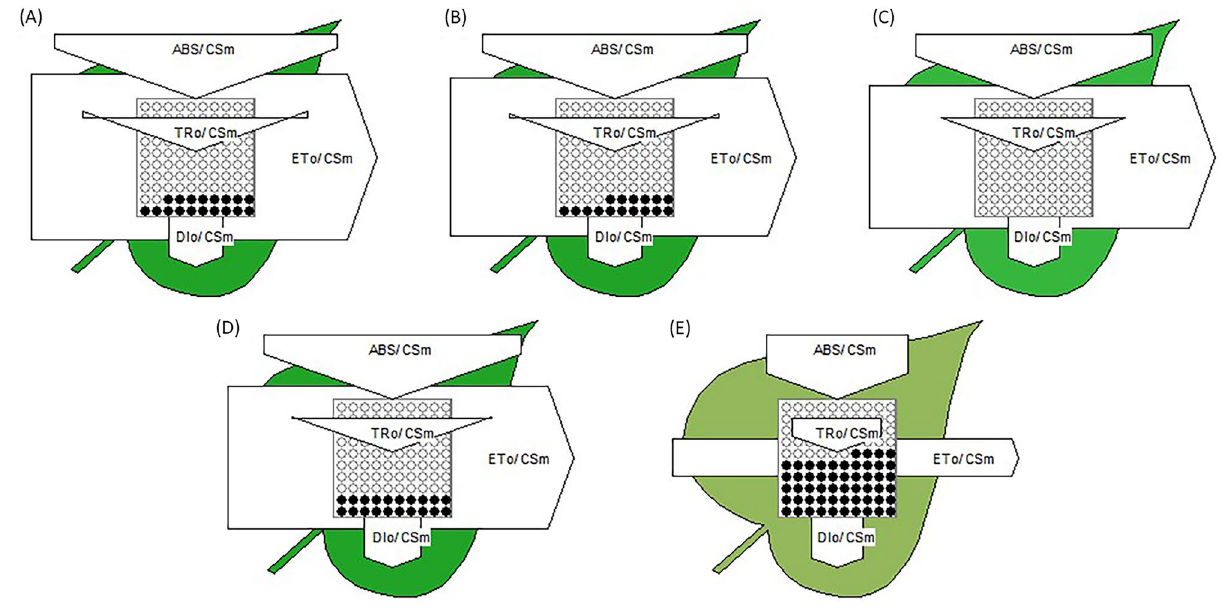
Figure 5. Energy pipeline leaf model of phenomenological fluxes (per cross section, CS) in L. minor fronds when subjected to various concentration of Cu, ( A ); control, ( B ); 10.0 µM, ( C ); 20.0 µM, ( D ); 30.0 µM and ( E ); 40.0 µM.